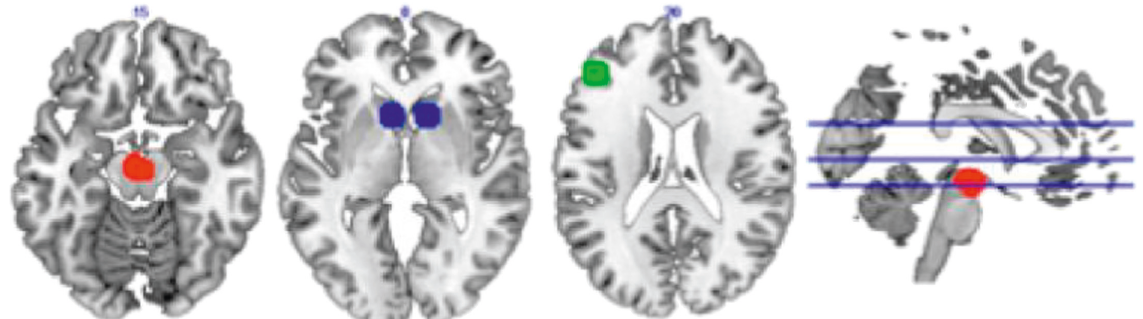
Figure 1: Map demonstrating the selected mesocorticolimbic structures in the dopaminergic reward network, using peak coordinates described by Ballard et al. [21]. Note: red � ventral tegmental area (VTA), blue � nucleus accumbens (NAcc), green � dorsolateral prefrontal cortex